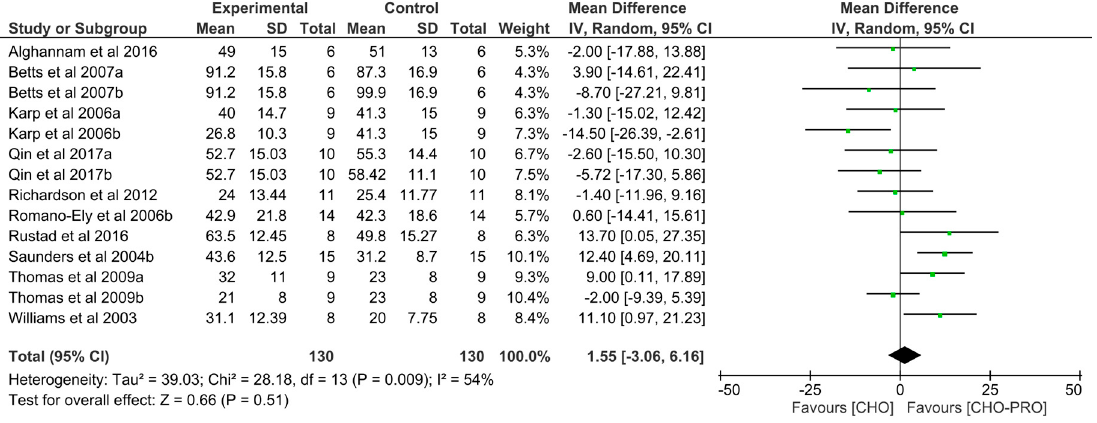
Figure 5. Effect of CHO-PRO intake during recovery on TTE performance compared to CHO. CI: confidence interval; MD: mean difference.